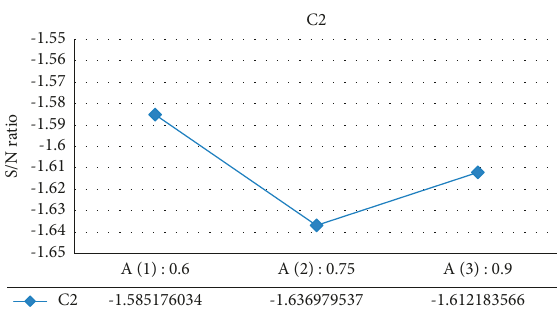
Figure 8: Graph of the average S / N ratio for each level of the POPSIZE factor of the PSO algorithm in solving the model.